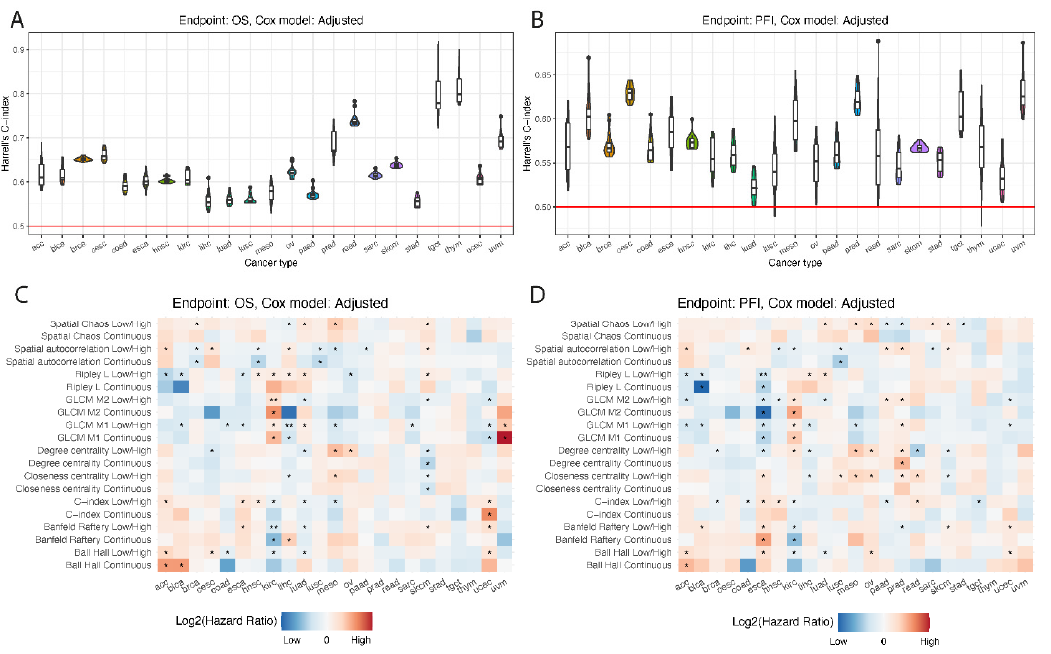
Figure 4. Result of survival analysis. Top: Distribution of Harrell’s concordance index from survival analysis across different cancer types for overall survival ( A ) and progression-free interval ( B ). Bottom: Heatmaps presenting hazard ratios per cancer type and spatial-measure scale (continuous or discretized) for overall survival ( C ) and progression-free interval ( D ). Single star indicates p -value lower than 0.05, and two stars lower than 0.01.